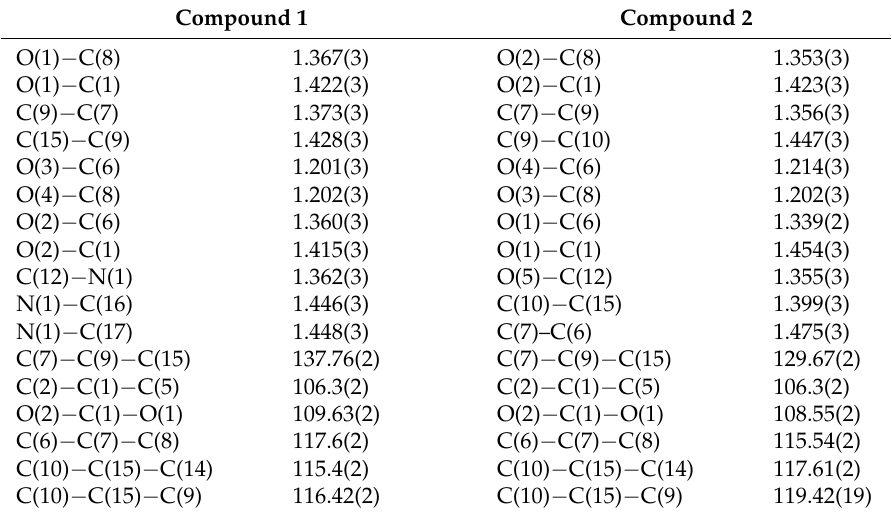
Table 1. Selected bond lengths (Å) and bond angles ( ◦ ) of the two compounds.